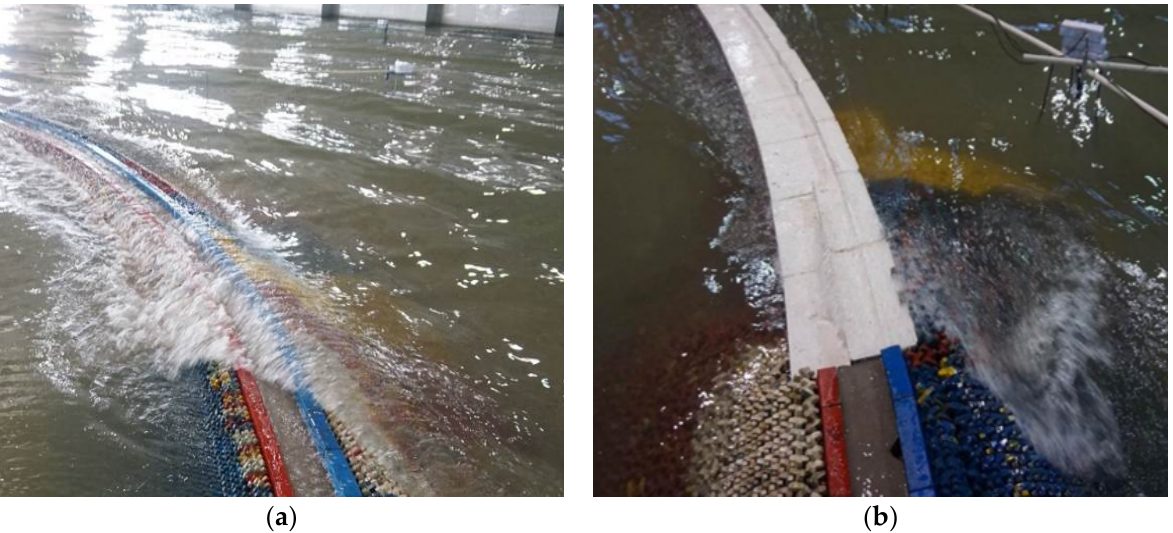
Figure 6. Overtopping and whirlpool phenomenon at the transition under the action of waves: ( a ) overtopping at a high water level; ( b ) whirlpool phenomenon. The wave overtopping was collected under the action of 5 ◦ , 15 ◦ , 35 ◦ , and 75 ◦ waves at